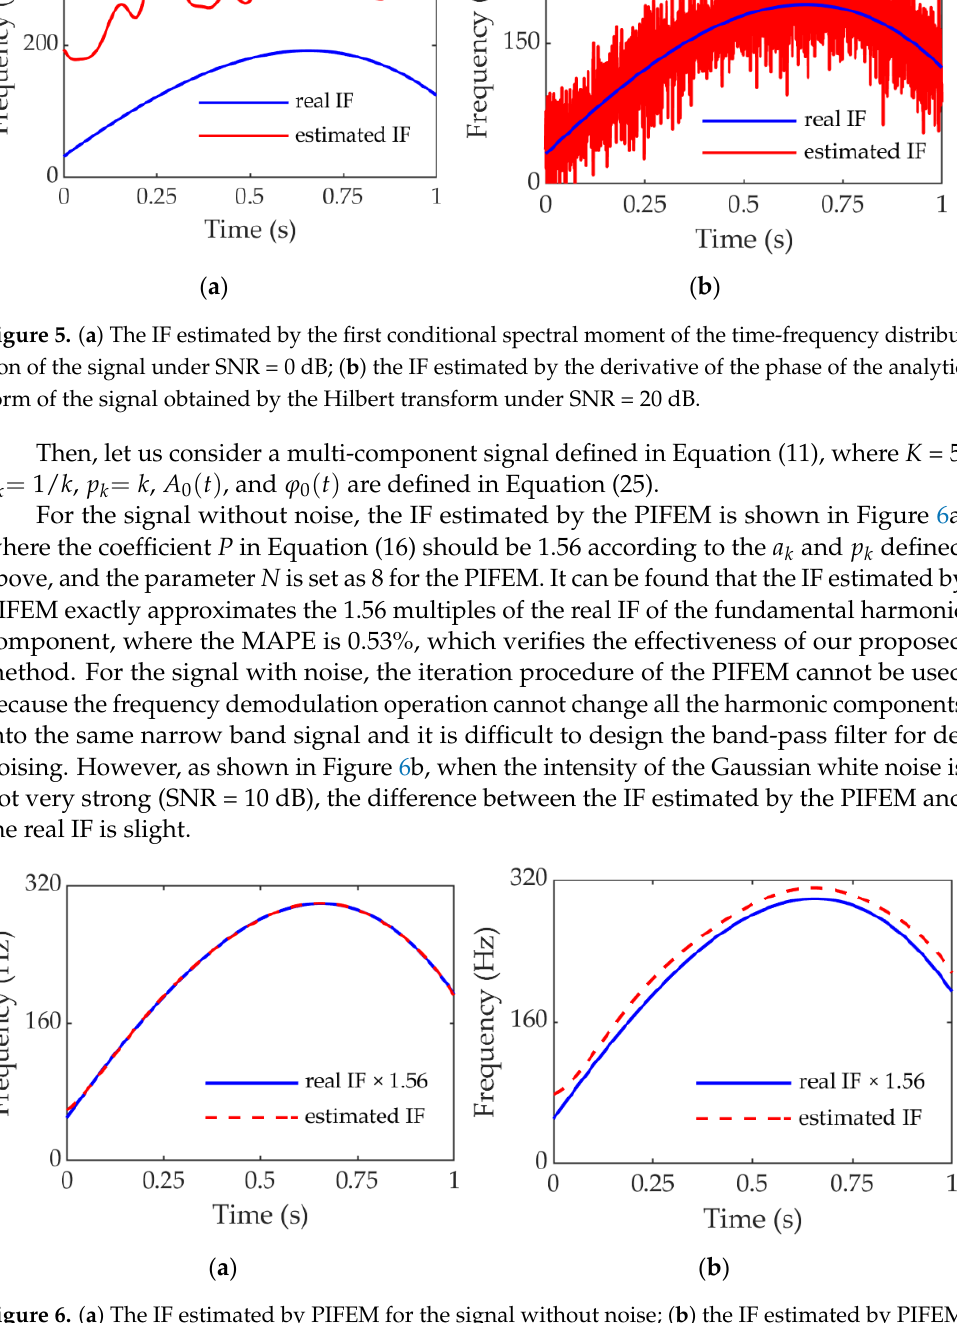
( b ) Figure 7. ( a ) The amplitude spectrum of the signal before resampling; ( b ) the amplitude spectrum of the signal after resampling.